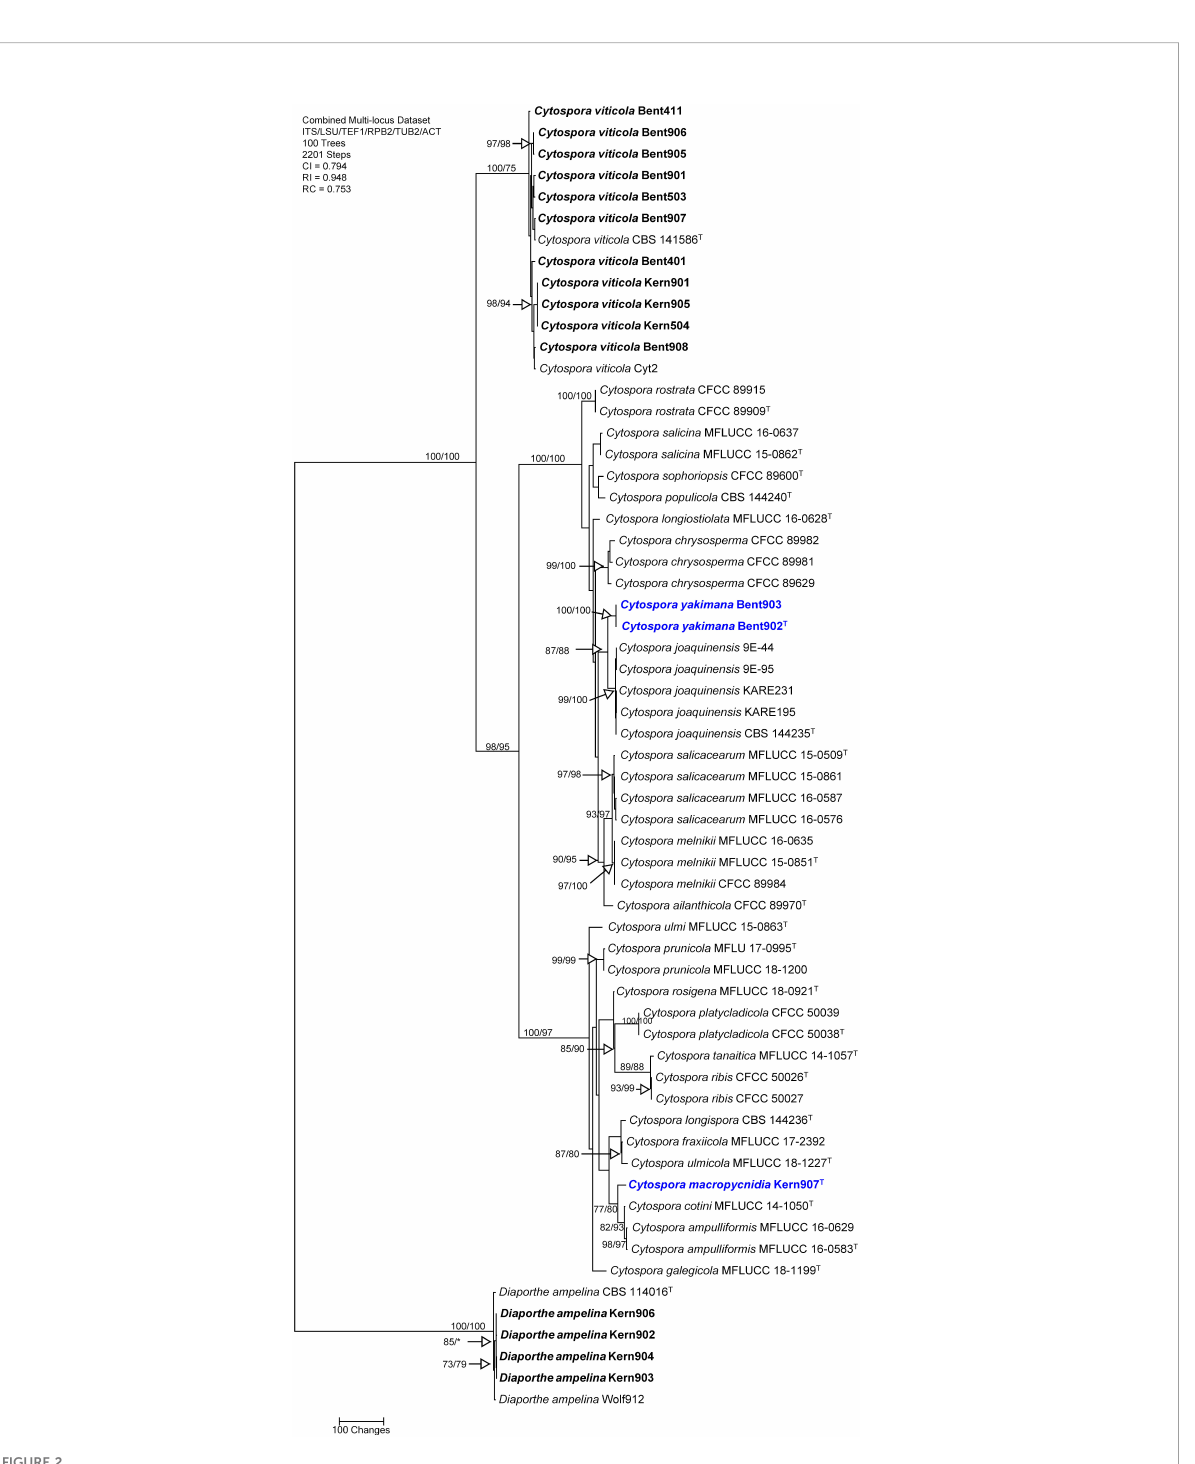
FIGURE 2 Phylogram generated from maximum parsimony analysis of the genus Cytospora based on a combined ITS, LSU, TEF-1 a , RPB2, TUB and ACT sequence dataset. Bootstrap support values for MP and ML equal to or greater than 70% are presented. The tree is rooted to Diaporthe ampelina (CBS 114016 and Wolf912). The new isolates are in bold and isolates of new species are in blue. Ex-type strains are noted with superscript T.